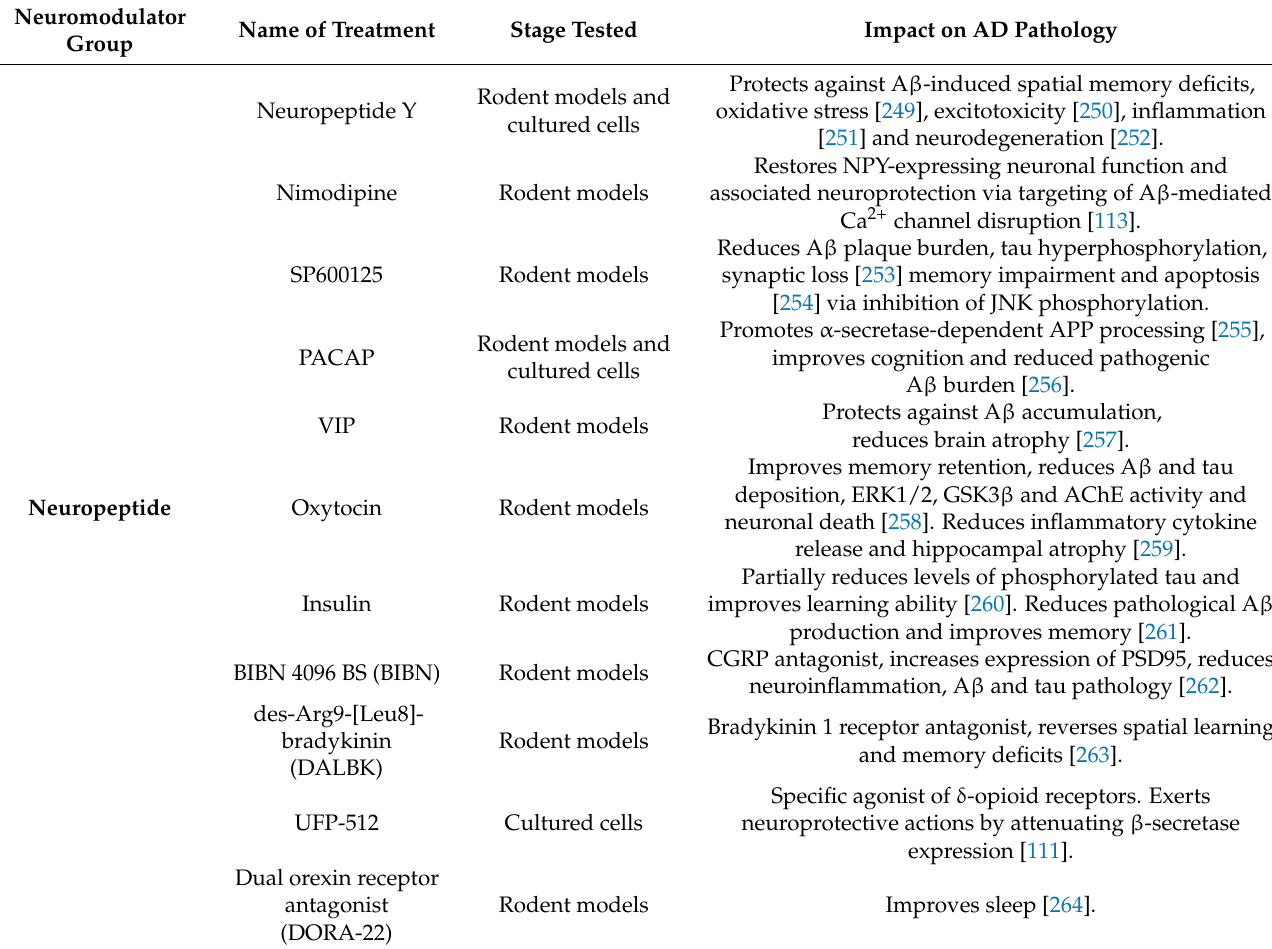
Table 1. Potential neuromodulator-based therapeutics for Alzheimer’s disease and their reported impacts on